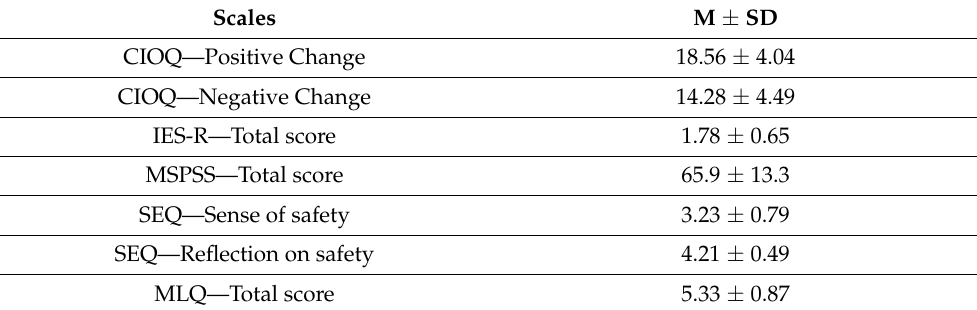
Table 1. Distribution of the analysed features in scales.